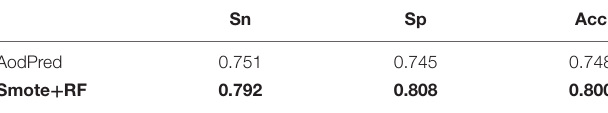
TABLE 3 | Compared the best results in our research with the results of